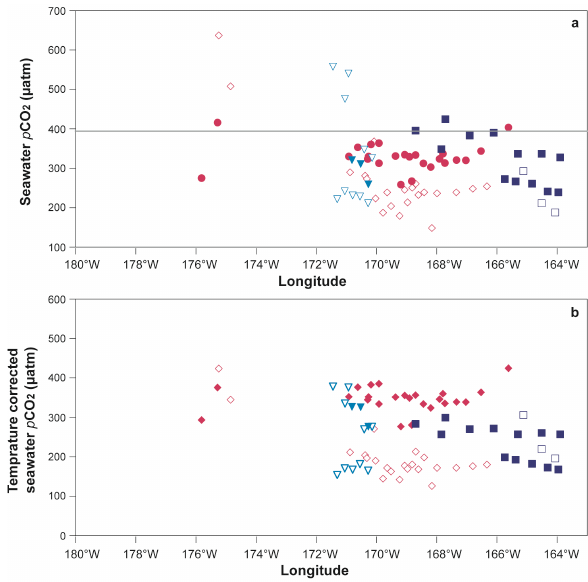
Figure 9 . Surface seawater p CO 2 ( µ atm; panel a) and temperature corrected seawater p CO 2 ( µ atm; panel b) plotted against longitude for the southern Bering Sea shelf for the following regions: (1) between Nunavak Island and Pribilof Islands (pink symbols); (2) south of Pribilof Islands (blue symbols), and; (3) SE Bering Sea shelf (turquoise symbols). Temperature corrected seawater p CO 2 was based on corrected to 0°C using the empirical relationships of Takahashi et al ., 2002. Spring and summer data was shown with closed and open symbols respectively. In the panels, the nearshore to offshore transition is shown from right to left (i.e., east to west).